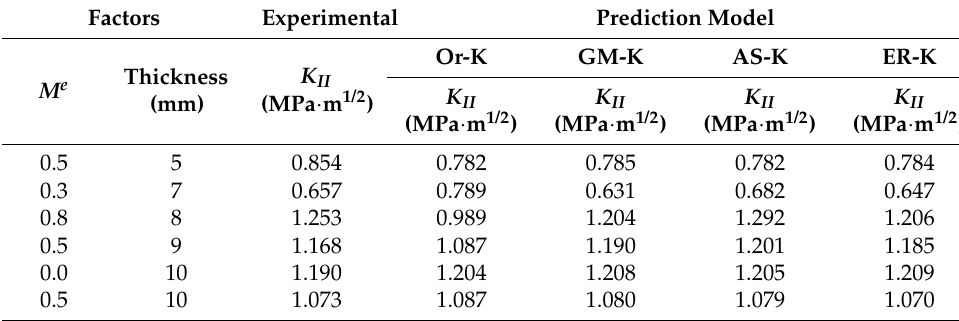
Table 4. Mode II fracture toughness from models’ testing